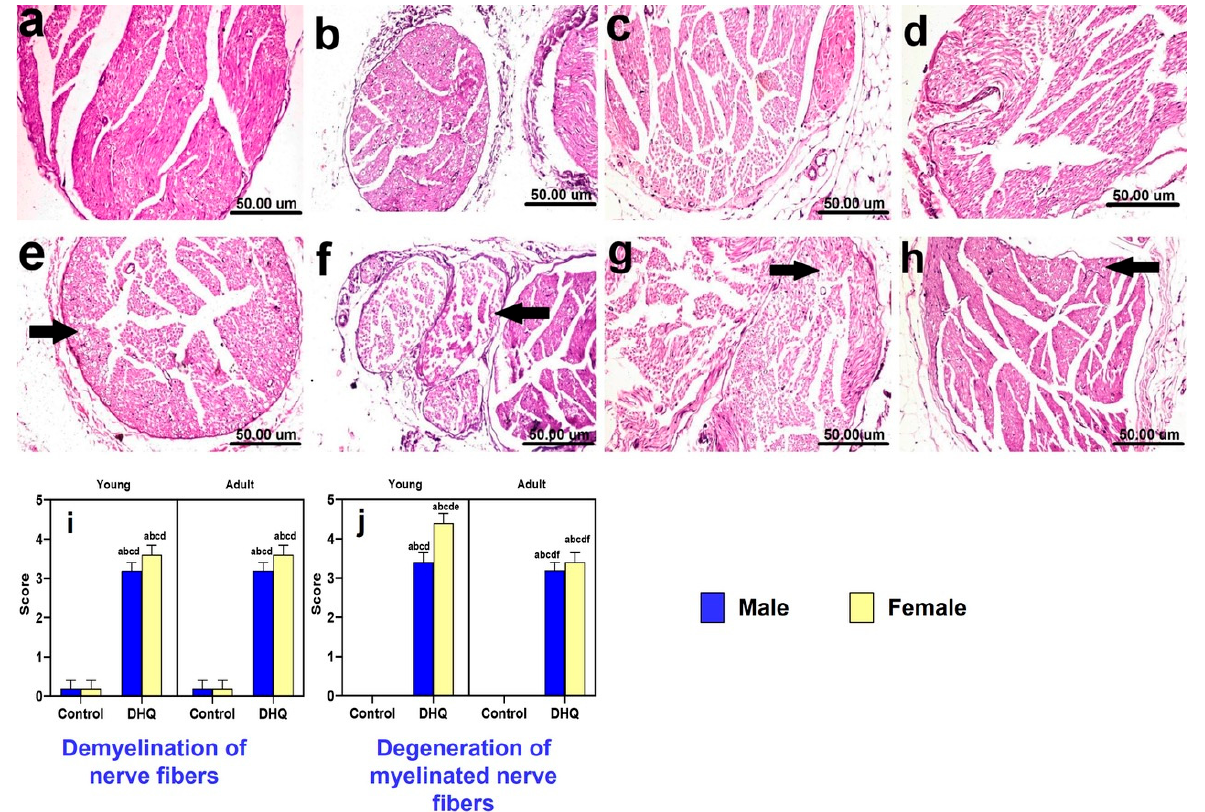
Figure 7. Histological hematoxylin and eosin-stained sections from sciatic nerves of ( a – d ) control rats, ( a ) young male, ( b ) young female, ( c ) adult male, and ( d ) adult female, showing the normal histological architecture of nerve fascicles containing nerve fibers and surrounded by perineurium connective tissue. ( e ) DHQ young male showing demyelination of nerve fibers (black arrow). ( f ) DHQ young female showing marked Wallerian demyelination of nerve fibers (black arrows) and dark degenerated myelinated nerve fibers. ( g ) DHQ adult male showing demyelination of nerve fibers (black arrow). ( h ) DHQ adult female showing demyelination of nerve fibers (black arrow) (scale bar 50 um). Graphical representation of histopathological scores for ( i ) demyelination of nerve fibers and ( j ) degeneration of myelinated nerve fibers. Each bar with a vertical line represents the mean ± S.D. of 5 rats per group. a vs. control young male, b vs. control young female, c vs. control adult male, d vs. control adult female, e vs. treated young male, and f vs. treated young female using three-way ANOVA followed by Tukey’s post hoc test; p < 0.05. DHQ; diiodohydroxyquinoline.